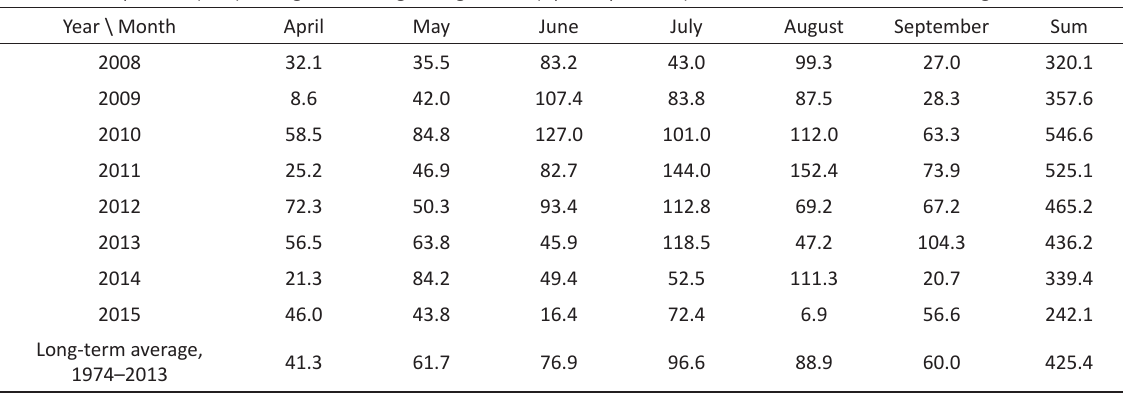
Table 3. Precipitation (mm) during the maize growing season (April-September) in 2008–2015, Kaunas Meteorological Station